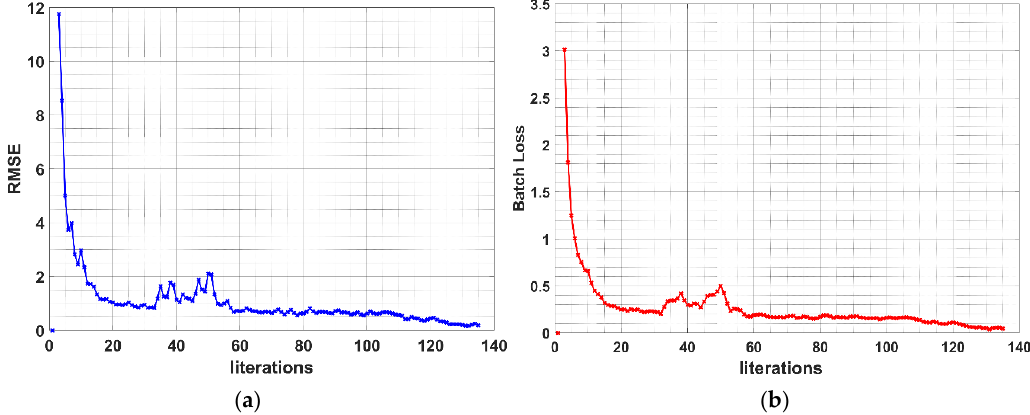
Figure A2. Overview of TPM.